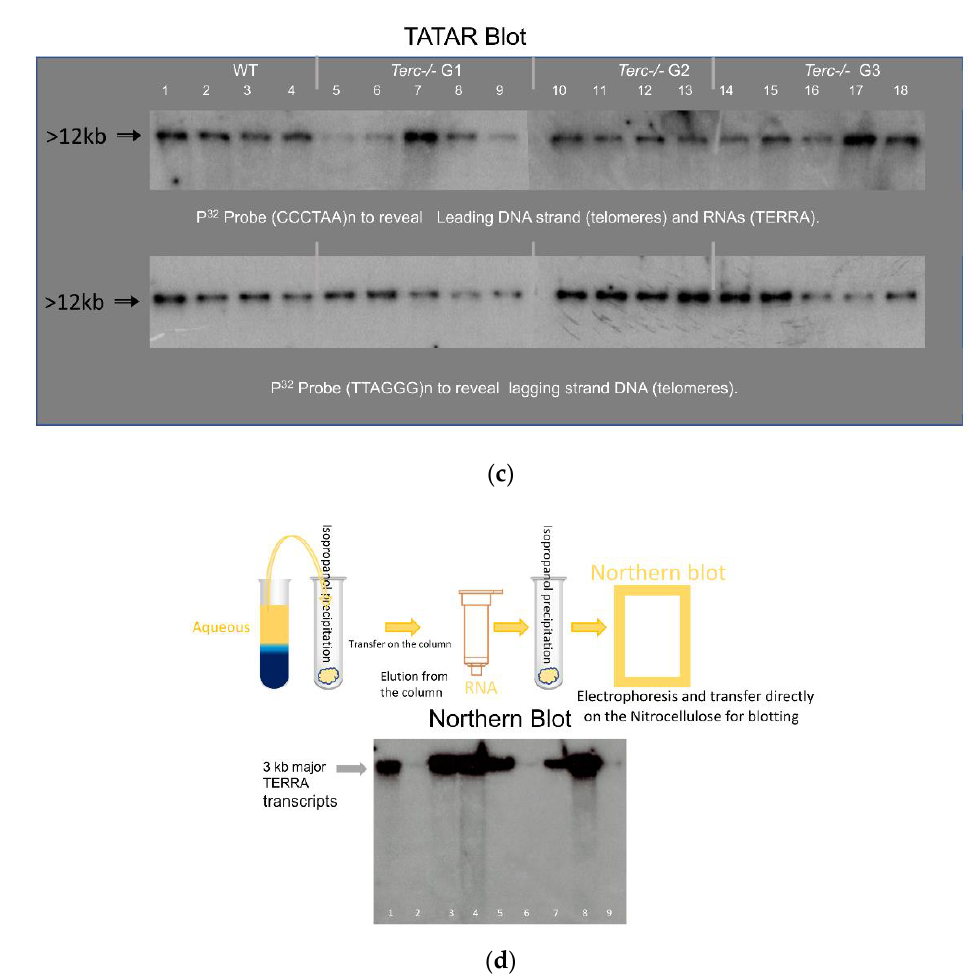
Figure 1. Telomeres associated TERRA. ( a ) DNA-RNA complex (Tatar: Telomeres associated TERRA RNA). Total nucleic acid preparations were analyzed after enzymatic digestion/Msp1. Electrophoresis was run on acrylamide gel (8%) for 3 h and after overnight electro-transfer on nitrocellulose membrane is hybridized with a gamma-ATP 32 P-labelled probe against the (TT/UU)AGGG telomeric motif, probe (CCCTAA) 8n to reveal Leading DNA strand (telomeres) and RNAs (TERRA). Left: DNA prepared from laboratory mouse tissues C57BL/6 (1: Brain; 2: testis; 3: sperm), 129/sv (4: Brain; 5: testis; 6: sperm), B6/D2 (7: Brain; 8: testis; 9:sperm), and 10: human sperm. Middle: three independent sperm samples. Right: Ethidium bromide staining of markers and three human sperm samples. M1 and M2 molecular markers. ( b ) Left: Enzymatic digestion, BamH1 (1–4), Msp1 (5–8), HpaII (9–12), Alu1 (13–16), (from left to right: Balb/c, B6/D2, C57BL/6 sperm, and human saliva). After enzymatic digestion, samples were run on an acrylamide gel (8%) for 3 h and after were transferred to a nitrocellulose membrane hybridized with an oligo labeled gamma-ATP P 32 Probe (CCCTAA) 8n to reveal Leading DNA strand (telomeres) and RNAs (TERRA). Middle two exposures of the same membrane: Agarose gel (0.8%) classical standard Southern blot, with one step of 45 min 0.5 M NaOH treatment (to remove RNAs and denature double-stranded DNA) before electro-transfer on nitrocellulose membrane and hybridization with the same probe to reveal the (TT/UU) AGGG telomeric motif. In addition to large fragments, a smear of shorter fragments is detected at longer exposure (right). ( c ) DNA/RNA complex with the same protocol as in a and b of mouse sperm from wild type and telomerase-negative ( Terc −/− ) mutants of the first three generations (G1, G2, G3). Germ cell biopsies of Terc −/− animals were kindly provided by Drs C. Gunes (Germany) and A. Londono (Paris). Top: P 32 Probe (CCCTAA) 8n to reveal Leading DNA strands (telomeres) and RNAs (TERRA). Bottom: P 32 Probe (TTAGGG) 8n to reveal Lagging strand DNA (telomeres). ( d ) Northern blot analysis of RNA processed from TRIzol-chloroform aqueous phase, high-level detection of major TERRA fragments in Brain and testes but the low level in sperm (extracted from the same number of cells 10 6 ). RNA:B6/D2: 1: Testes; 2: Sperm 3: Brain, C57BL/6: 4: Brain; 5: Testes; 6: Sperm, 129/sv: 7: Testes; 8: Brain; 9: Sperm. P 32 Probe (CCCTAA) 8n used to reveal RNAs (TERRA).